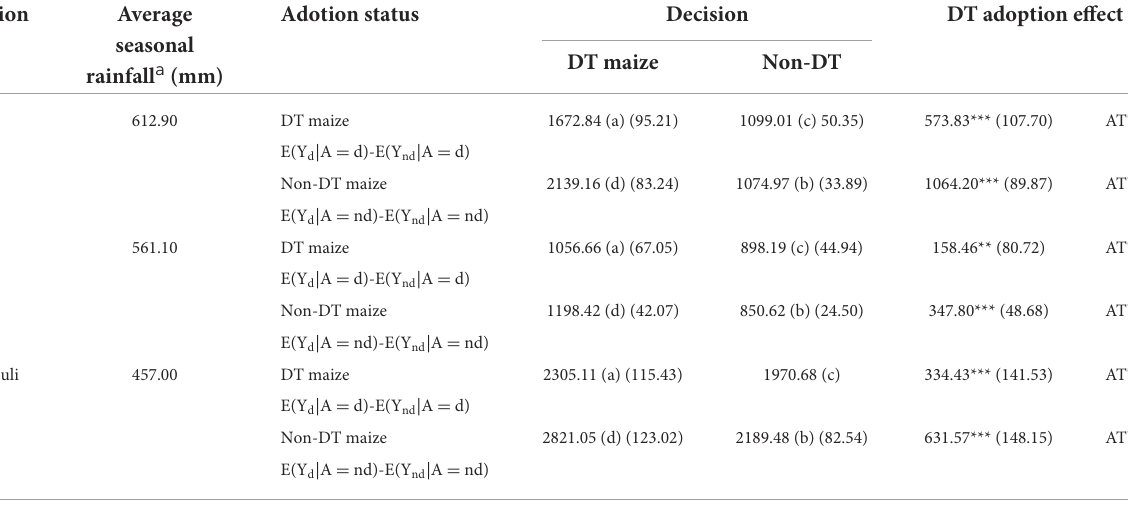
(ii) Outcome variable (Comparison): maize yield in kg per ha (DT vs.